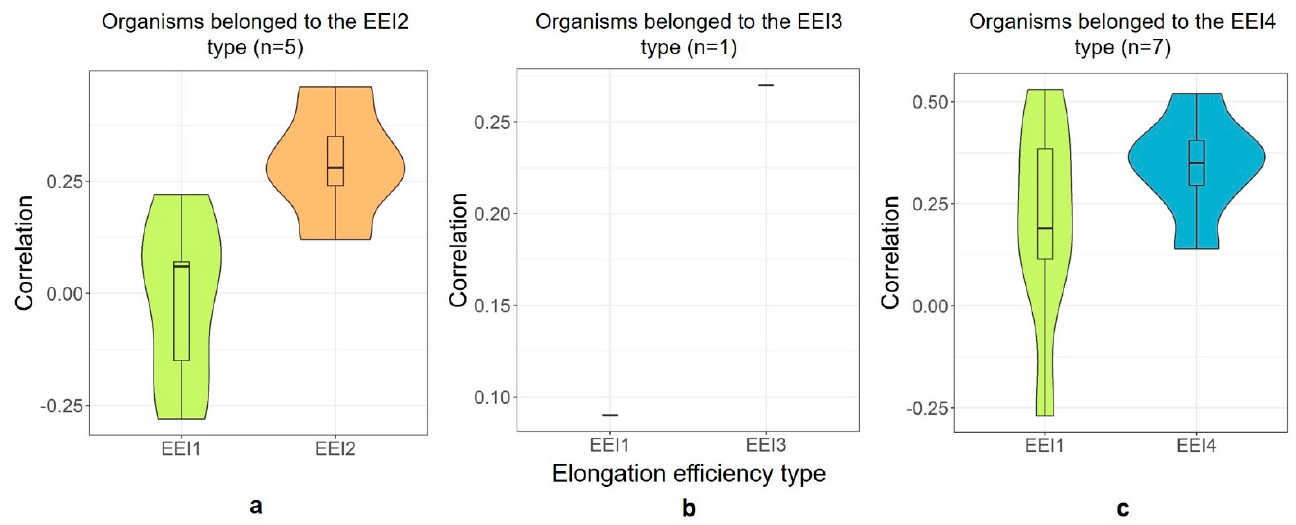
Figure 3. The distributions of the Spearman’s correlation coefficient values between protein abun- dance and EEI for the organisms belonged to the different elongation efficiency optimization types that take into account: number of secondary structures (EEI2, panel ( a )), energy of secondary struc- tures (EEI3, panel ( b )), codon bias and number of secondary structures (EEI4, panel ( c )). All these distributions are compared with the correlation between protein abundance and indices for codon bias-based index (EEI1) calculated for the same organisms.